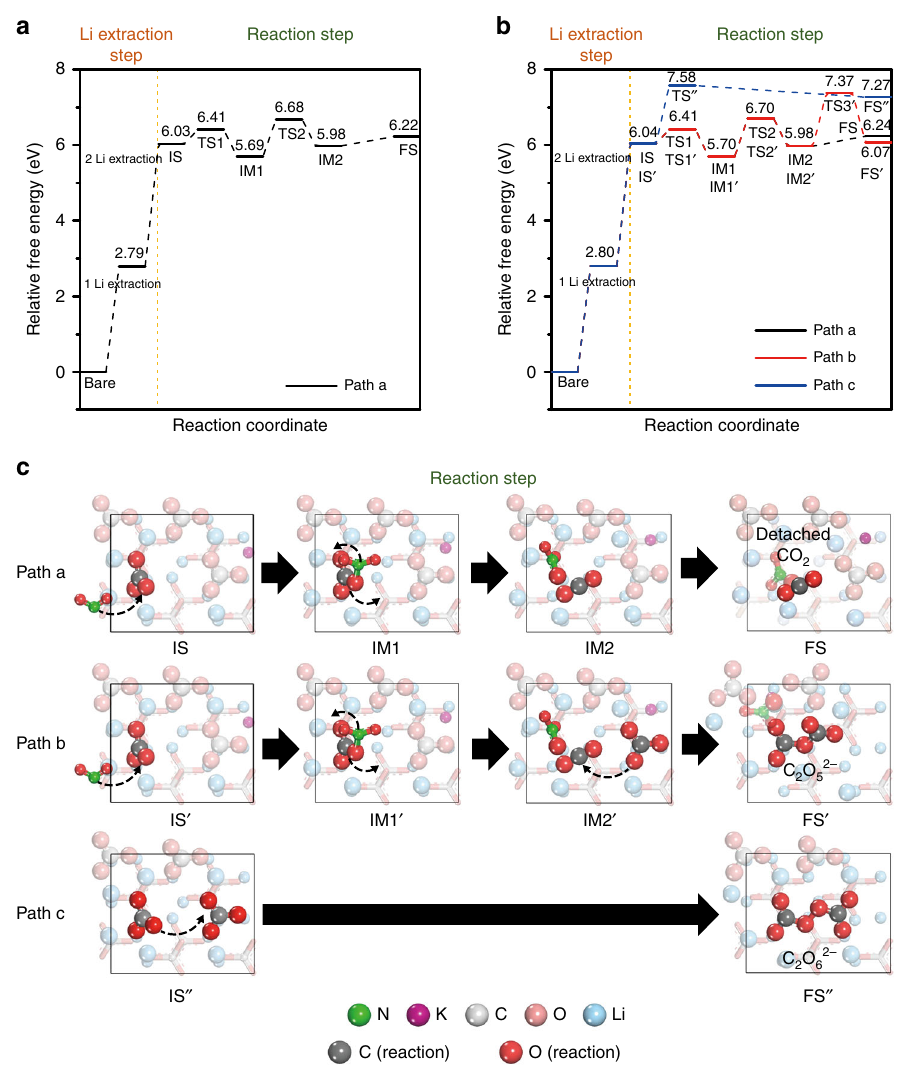
Fig. 3 Reaction mechanism of Li 2 CO 3 decomposition. a Reaction coordinate of one possible path a to produce CO 2 and NO 3 − (black line) at 100 °C. b Reaction coordinate of three plausible pathways (i.e., path a, path b to produce C 2 O 5 2 − and NO 3 − (red line), and path c to produce C 2 O 6 2 − (blue line)) at 150 °C. c Optimized con fi gurations on three plausible pathways for the reaction step corresponding to ( a ) and ( b ). IS, IM, and FS in each reaction mechanism represent the initial state, intermediate state, and fi nal state, respectively. The yellow dotted line is the boundary between the Li extraction step and the reaction step, and the numbers represent the relative free energies based on those of bare surface in ( a ) and ( b ). Nitrogen, potassium, carbon, oxygen, and lithium atoms are colored in green, purple, light gray, pink, and sky blue. For a clear view, the carbon, oxygen, and lithium atoms, which participate in the reaction, are colored in dark gray, red, and blue. Arrow dotted lines represent the movement of molecules from state to state. For a clear view, the molecules, except reacting molecules, were made to be translucent in ( c